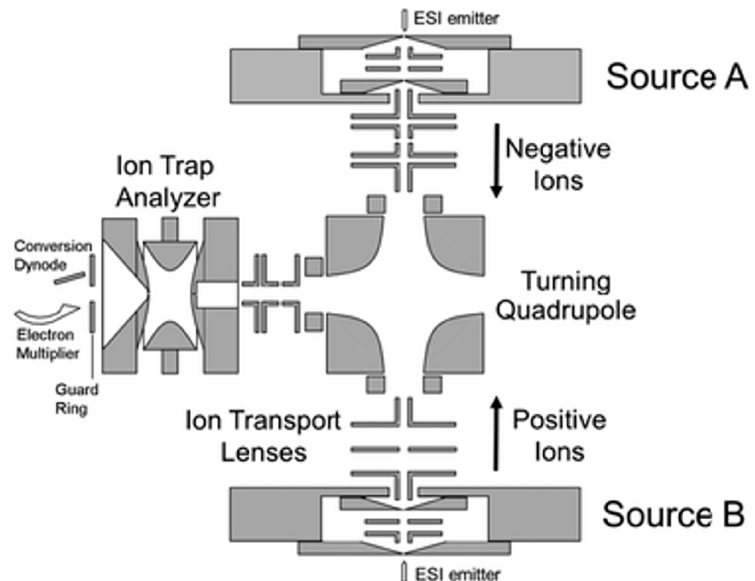
Figure 3. A sequential injection ion inlet system coupled with an ion trap mass spectrometer for gas-phase ion–ion reactions [69]. Adjusted and reprinted with permission from the Royal Society of Chemistry.